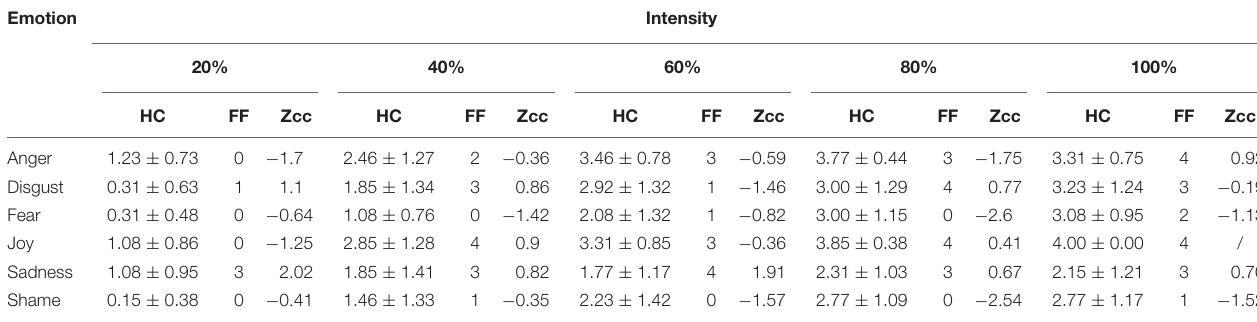
TABLE 3 | FF’s and controls’ performance in the Facial Emotion Recognition Task for all intensity